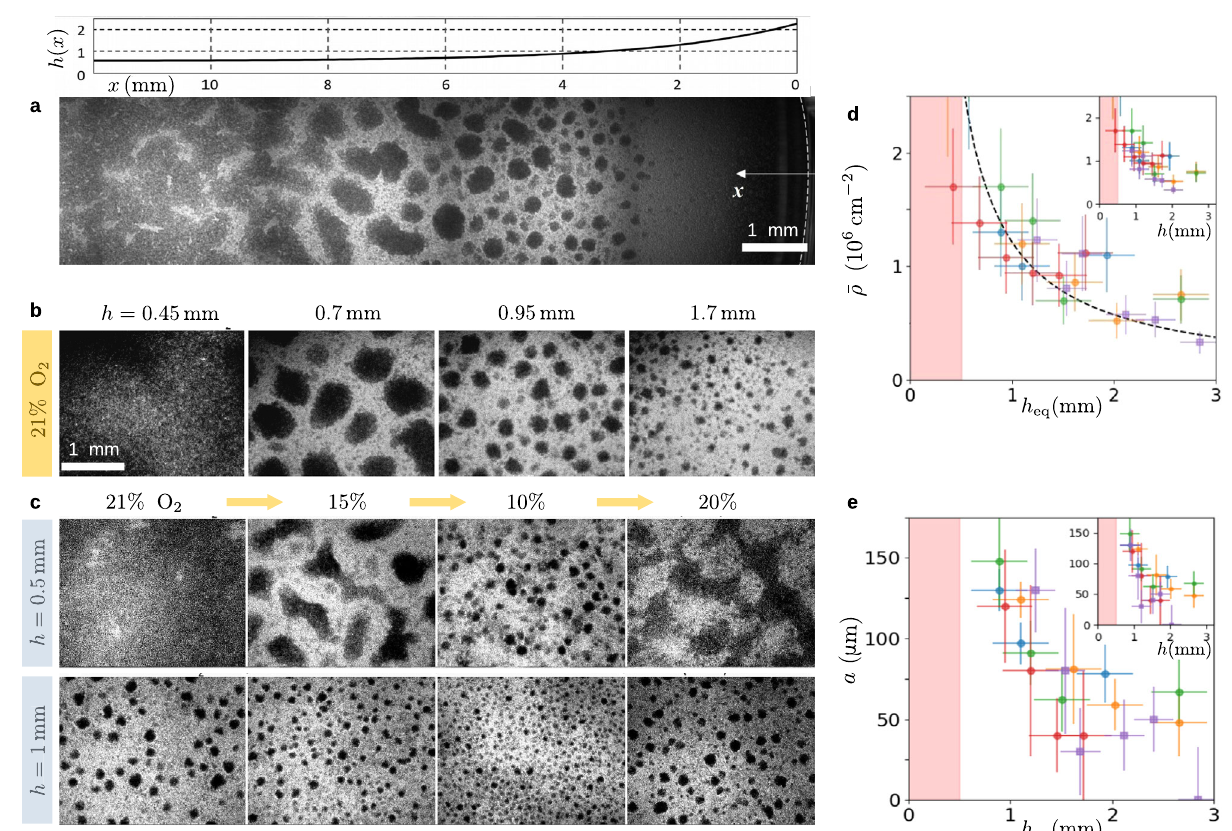
Fig. 2 | The size of aggregates is controlled by oxygen availability. a Domains belowthemeniscusatthedishborder.Themosaicimagewasobtainedbystitching confocaltile scans. h ( x ) is the height pro fi le,with x the distancefrom the dish wall. This experiment wasrepeatedindependently oncewith similar results. b In fl uence of medium height h on the domain size in a normal atmosphere. This experiment was repeated independently three times with similar results. c Effect of a step change intheoxygen content of atmosphere while keeping h fi xed. Each step lasts at least 6.6h. This experiment was repeated independently twice with similar results. d , e Average(projected)celldensity (cid:1) ρ and most probableaggregate radius